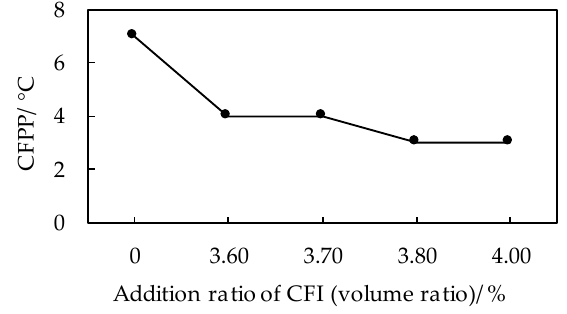
Figure 4. Effects of CFI on B100. Figure 4. E ff ects of CFI on B100.